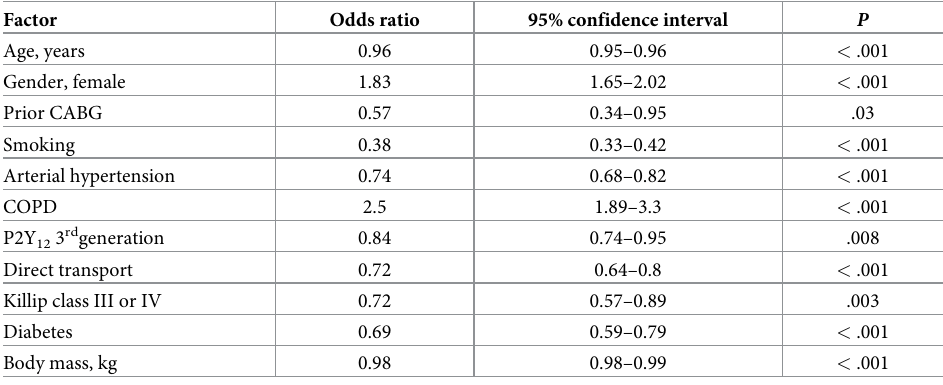
Table 5. Nominal logistic fit for MINOCA vs. MI-CAD patients admitted due to STEMI–multiple regression analysis.